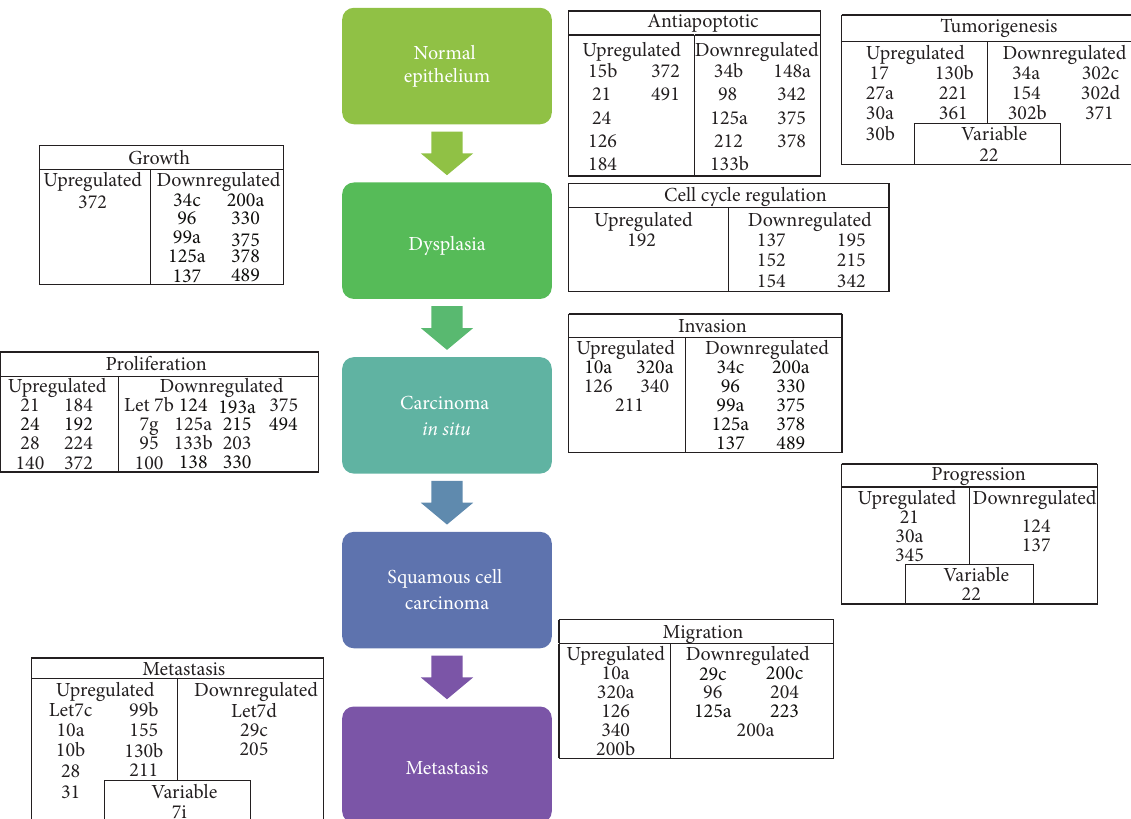
Figure 1: The role of miRs in regulating the transformation of normal squamous epithelial cells into carcinoma cells, ultimately resulting in metastasis (adapted from